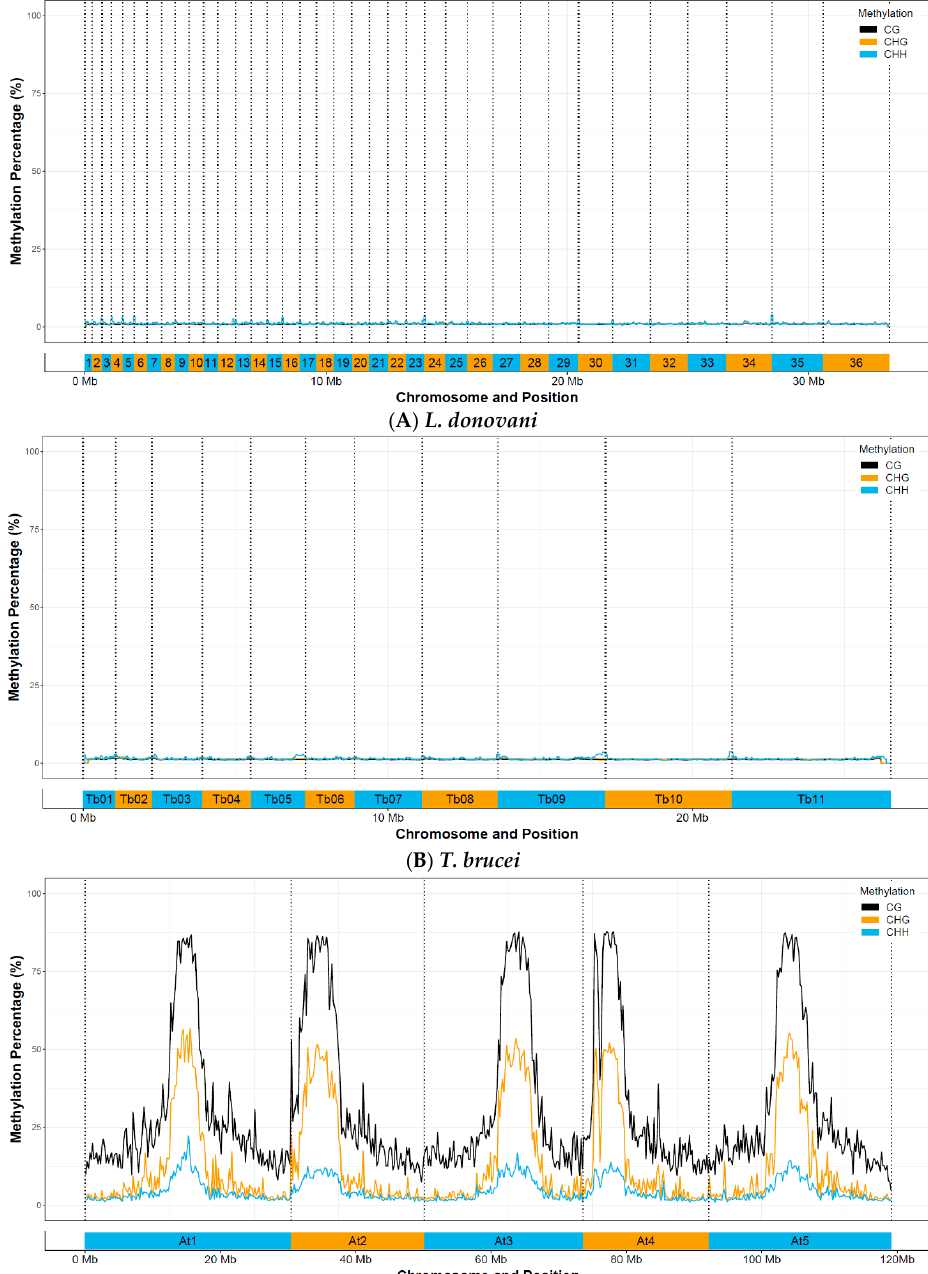
Figure 3. CpG, CHG, and CHH genome-wide methylation patterns in ( A ) Leishmania donovani BPK282 P3 promastigotes (36 chromosomes) , ( B ) Trypanosoma brucei brucei TREU927 (11 chromosomes), and ( C ) Arabidopsis thaliana Col-0 (5 chromosomes). Data was binned over 10,000 positions to remove local noise and variation.